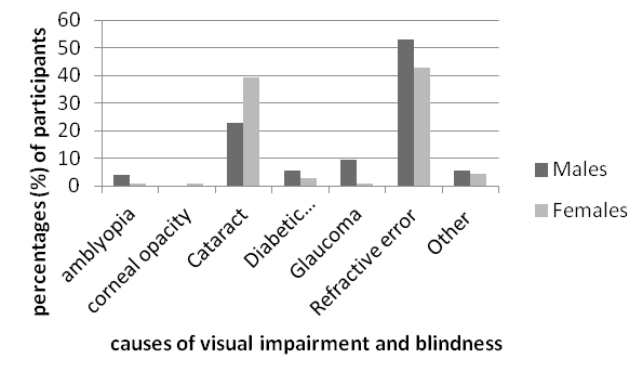
Figure 2: The causes of visual impairment and blindness in the left eyes of males and